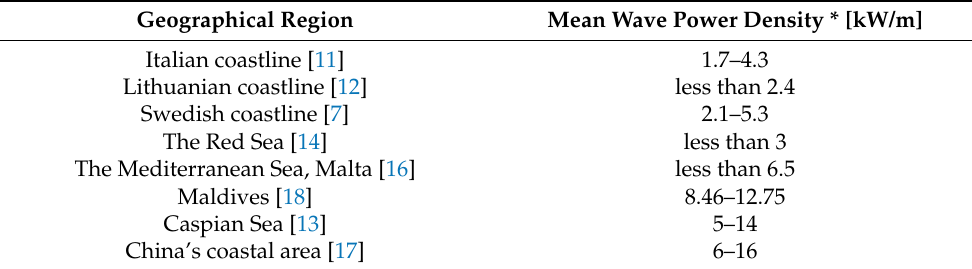
Table 1. Wave power density in different